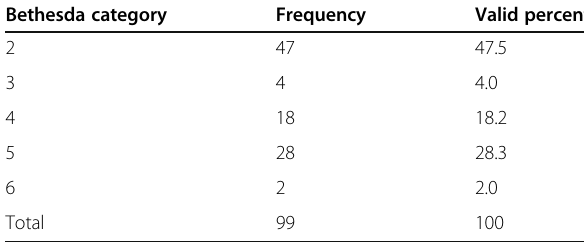
Table 5 Showing cytological results of the nodules according to Bethesda classification Bethesda category